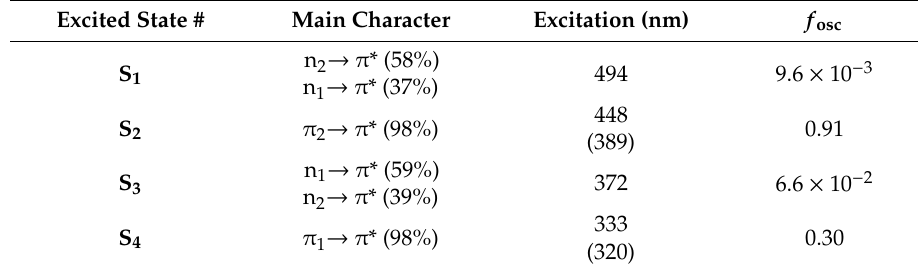
Table 4. Calculated excitation energies, band maxima assignments and oscillator strengths ( f osc ) of E -AZO2 (experimental values from UV / Vis analysis are shown in